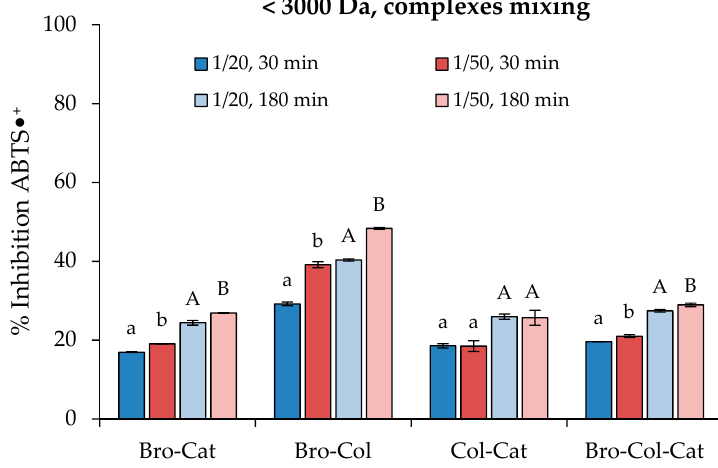
Figure 4. Comparison of the percentage of inhibition of the ABTS radical by mixing peptides-min- erals complexes, for the < 3000 Da fraction, 1/20 and 1/50 E:C ratios, at time 30 min and 180 min (Bro = bromelain, Cat = cathepsin B, Col = collagenase B). Columns label interpretation: (i) for each mix, lowercase letters indicate differences at 30 min between 1/20 and 1/50 ratio; (ii) upper case letters indicate differences at 180 min between 1/20 and 1/50 ratios for each mix.